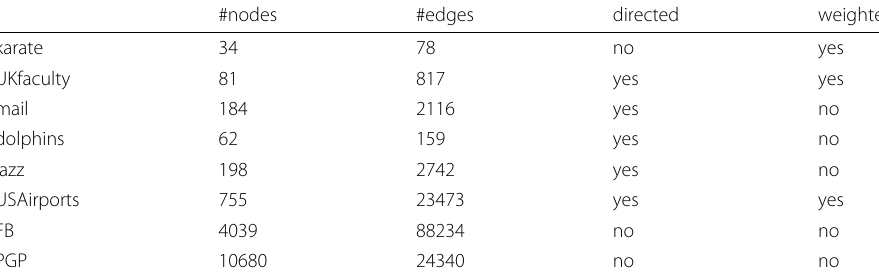
Table 1 Real-world networks